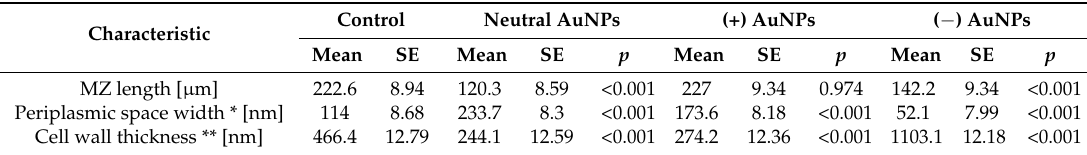
Table 1. The effect of AuNPs on the roots: length of MZ, width of periplasmic space and thickness of the cell wall compare to the control